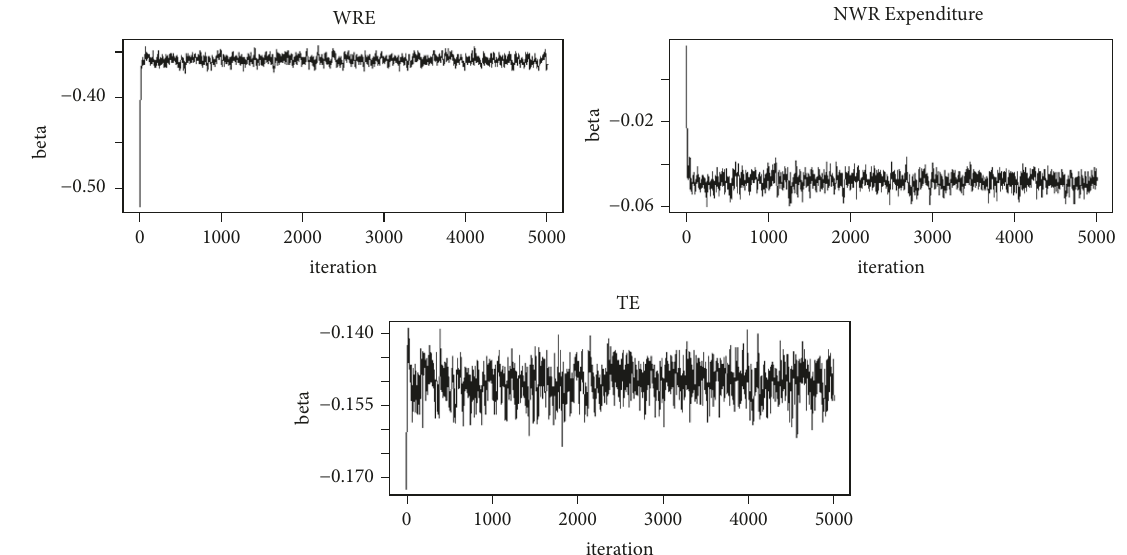
Figure 1: Trace plots for regression estimate under Bayesian median regression (𝜃 = 0.5) .